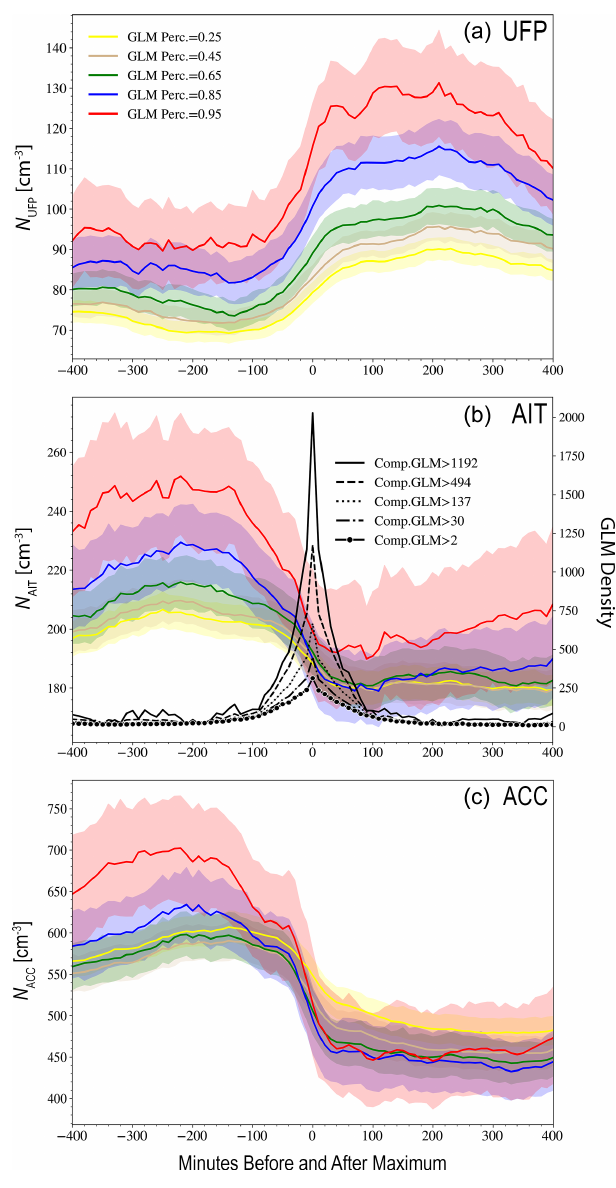
Figure 6. (a) Composite N UFP as a function of the maximum lightning density events for different lightning density percentiles. (b) Composite N AIT as function of the maximum lightning den- sity events for different lightning density percentiles. The compos- ite lightning frequency is shown for each percentile from continuous to dashed lines. (c) Composite N ACC as function of the maximum lightning density events for different lightning density percentiles (60m sampling height). The shaded area corresponds to confidence intervals of